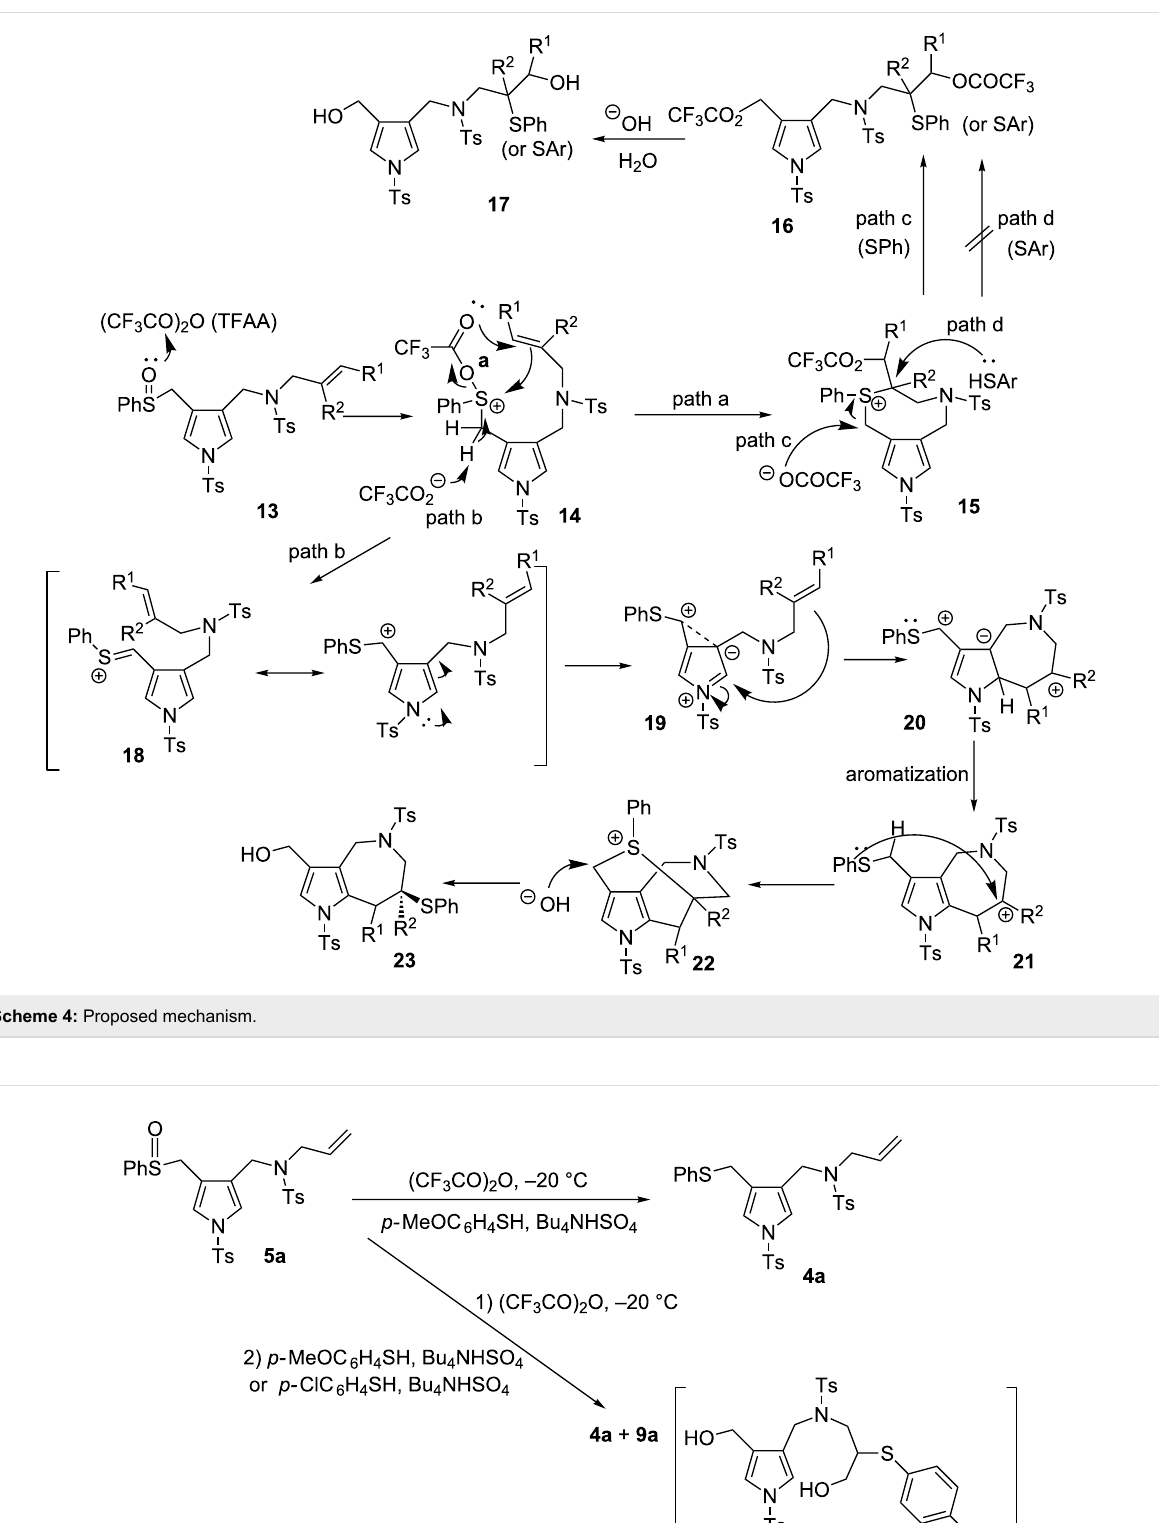
Scheme 5: Crossover